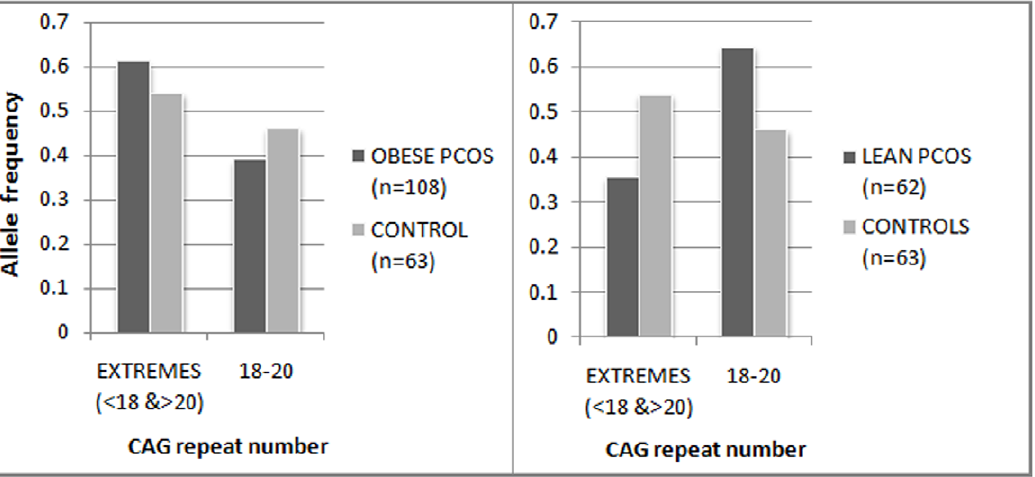
Figure 4. Relative frequency of extreme and middle range of CAG repeats among the obese PCOS/lean PCOS and controls.